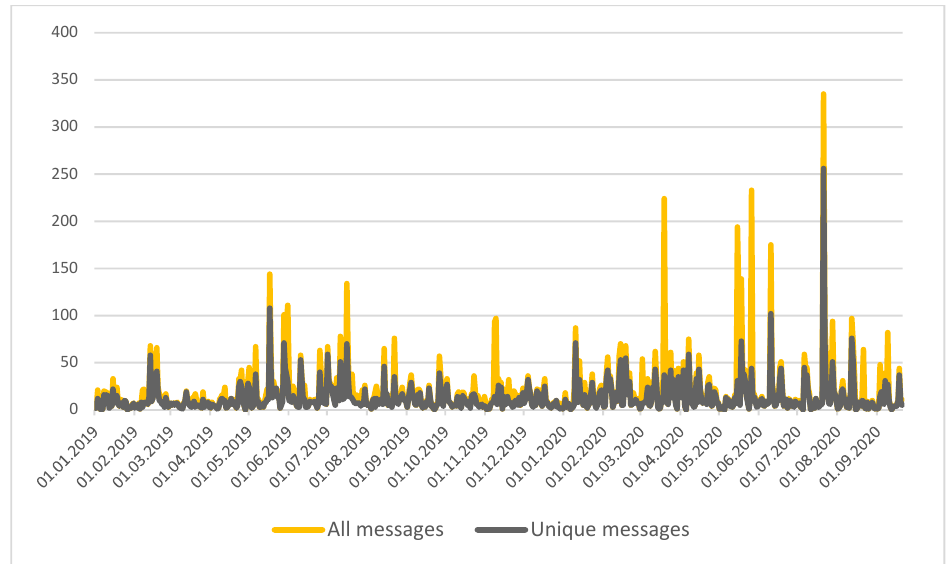
Figure 1. Dynamics of messages on the NEC construction.